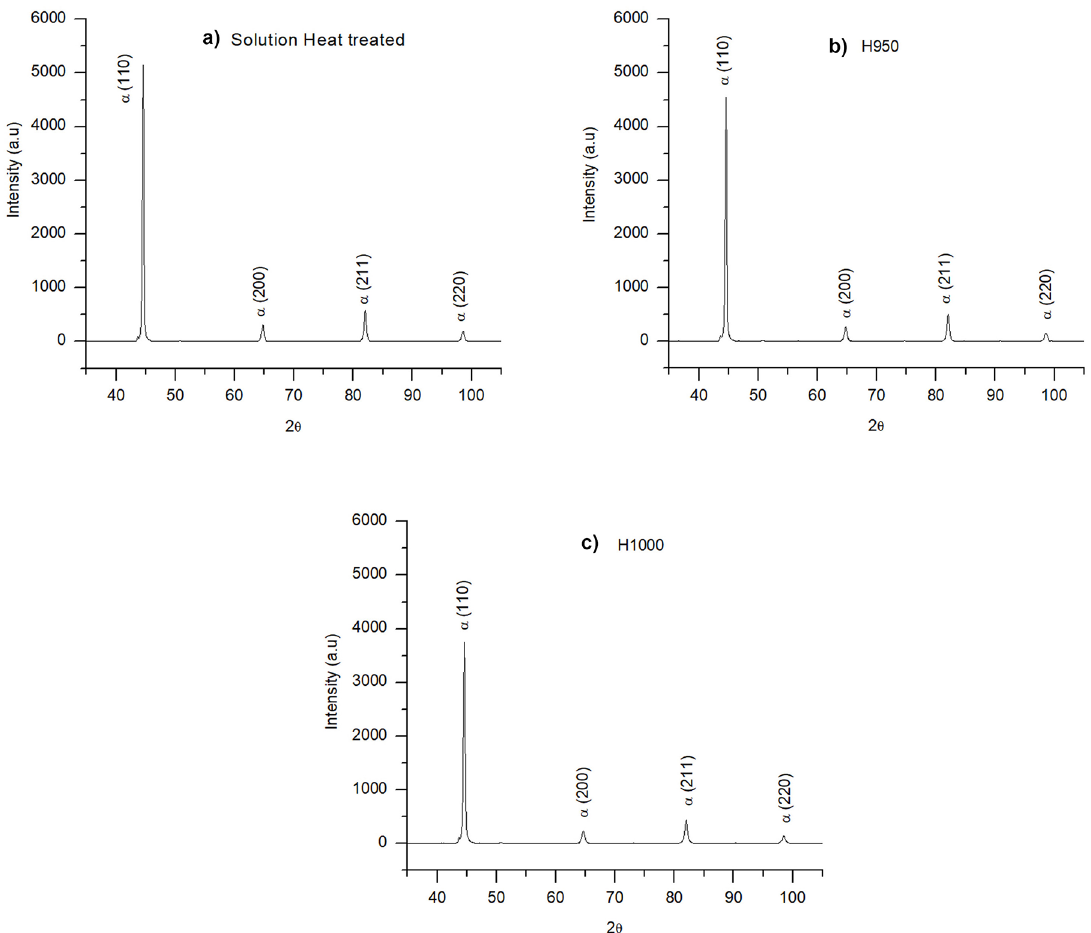
Figure 8. X-ray diffraction patterns of specimens: (a) solution heat treated; (b) H950 and (c) H1000.